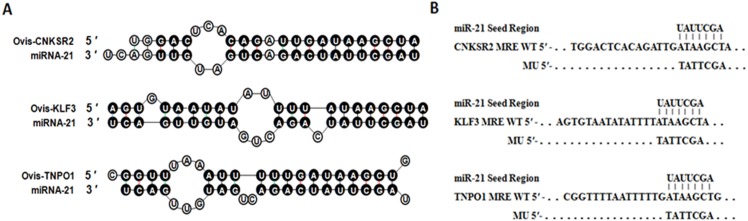
Duplex structure between miR-21 and target genes.(A) Duplex structure between miR-21 and MRE in the CNKSR2, KLF3 and TNPO1 mRNA predicted by mfold program (http://mfold.rna.albany.edu/?q=mfold). (B) Diagrams of WT or mutant MU constructs of miR-21 MRE in the CNKSR2, KLF3 and TNPO1 mRNA. Four nucleotides mutations were generated in the CNKSR2, KLF3 and TNPO1 binding sites to miR-21 seed region using pmiR-RB-REPORTTM.